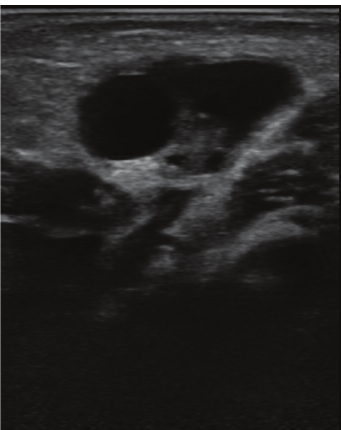
Figure 1: This B-mode US image shows the right ovary containing follicular cysts, in the right inguinal region.